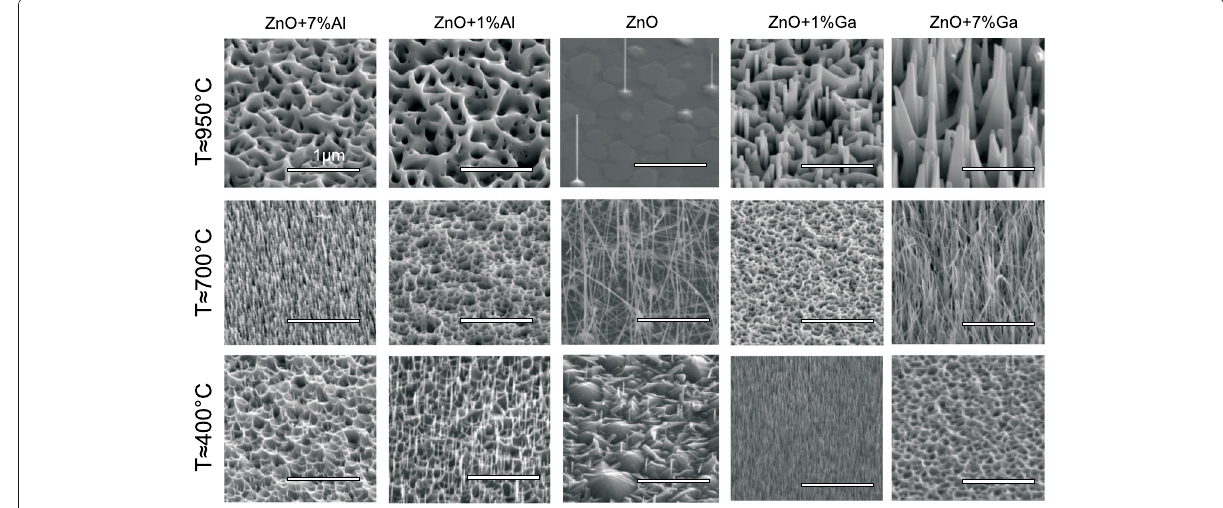
Fig. 2 Scanning electron microscopy images of the nanostructures for Al- and Ga-doped ZnO seed layers for selected temperatures and